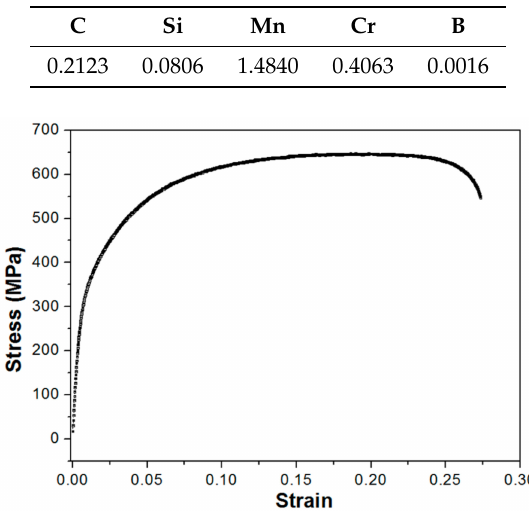
Figure 1. Engineering stress and engineering strain curve of 22MnB5 boron steel.